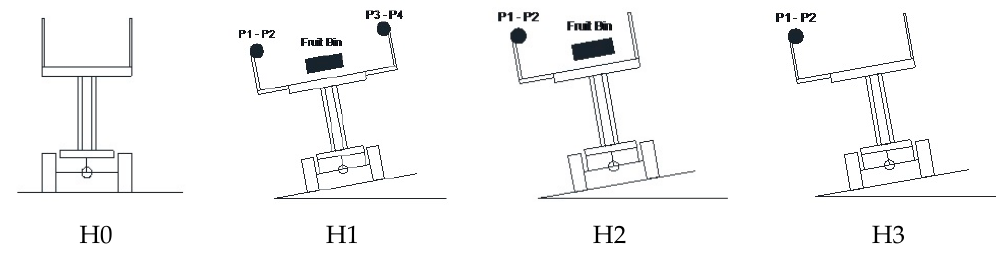
Figure 7. Settings during lateral stability assessment tests (front view).